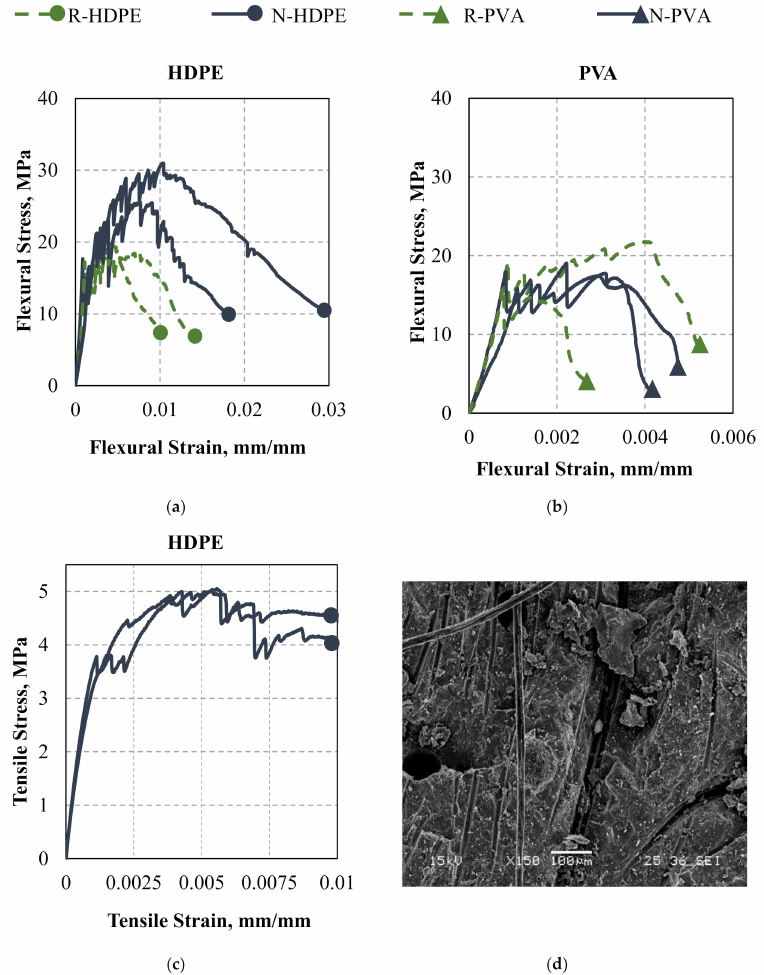
Figure 5. The 28-day performance of developed fiber-reinforced composites: flexural behavior of HDPE composites ( a ) and PVA composites ( b ); tensile response of Al 2 O 3 HDPE fiber (N-HDPE) composites ( c ) and fractured Al 2 O 3 HDPE fiber composite under SEM ( d